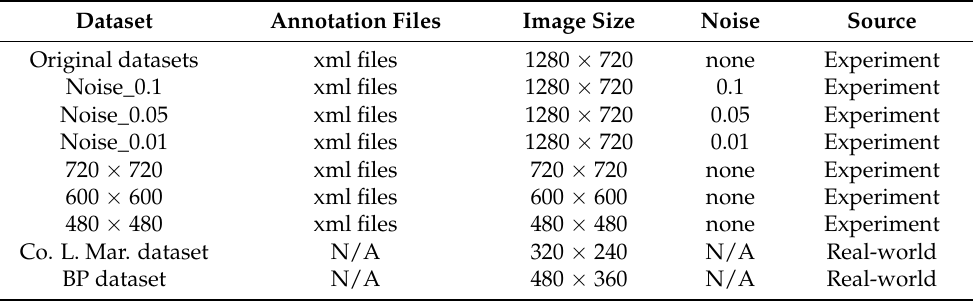
Table 3. Configuration of pre-trained models for the Faster R-CNN and YOLOv4